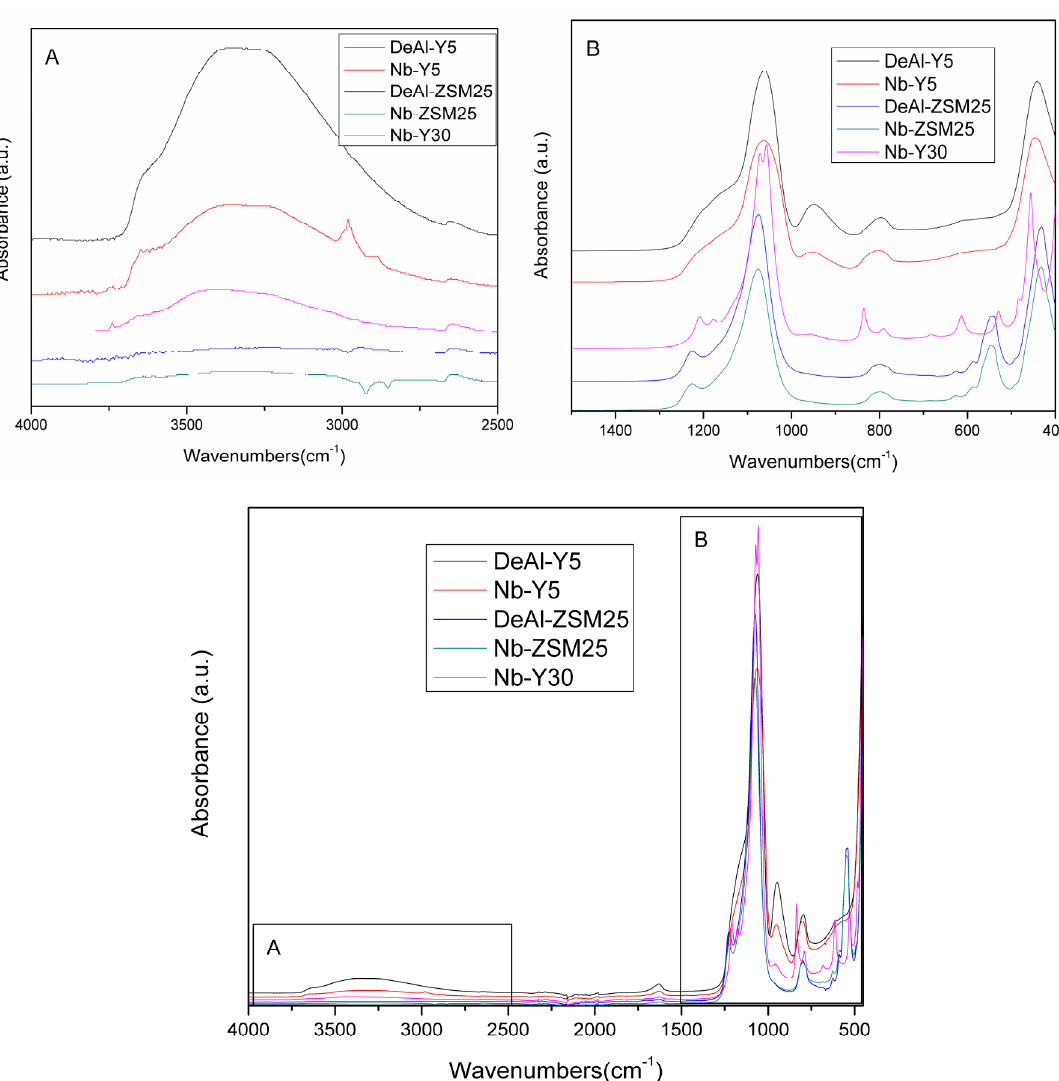
Figure 5. FTIR spectra of dealuminated Y5 (DeAl-Y5), Nb-Y30), ZSM-5 (DeAl-ZSM25) and Nb-ZSM25 samples with magnification on 4000–2500 ( A ) and 1500–400 cm − 1 ( B ) regions.